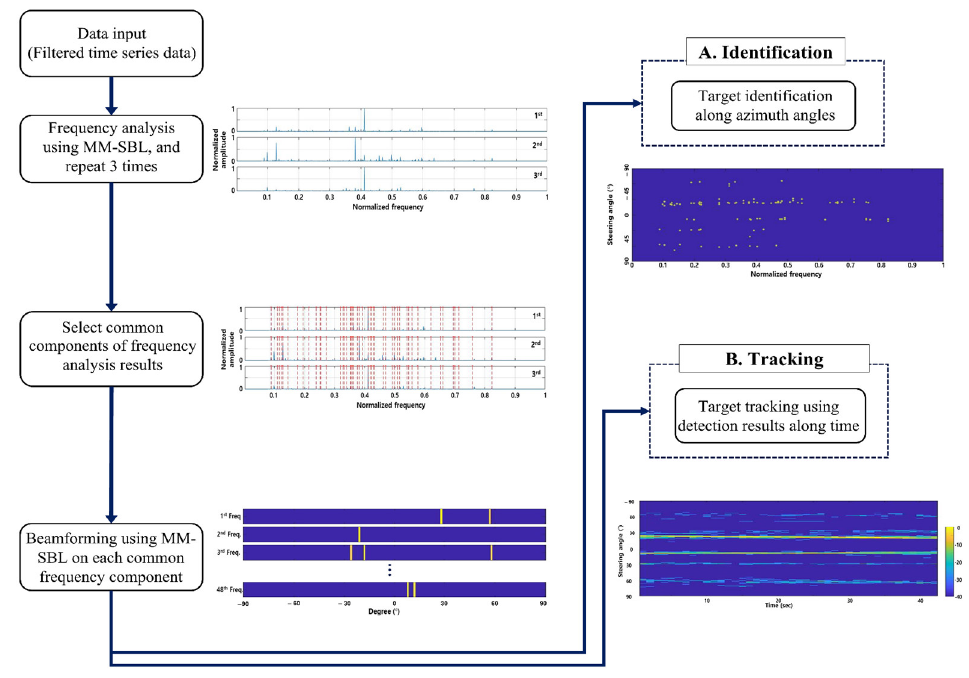
Figure 2. Flowchart of target identification and target tracking using MM-SBL.